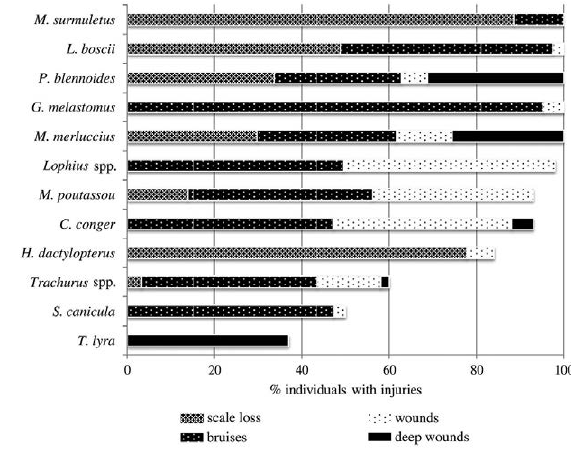
Fig. 2. – Percentage (%) of individuals with four types of injuries (scale loss, bruises, wounds and deep wounds) for each species.